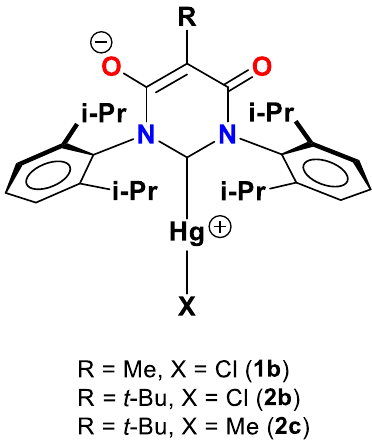
Figure 1. Mercury(II) complexes supported by anionic N -heterocyclic carbenes [Me-maloNHC Dipp ] − and [ t -Bu-maloNHC Dipp ] −